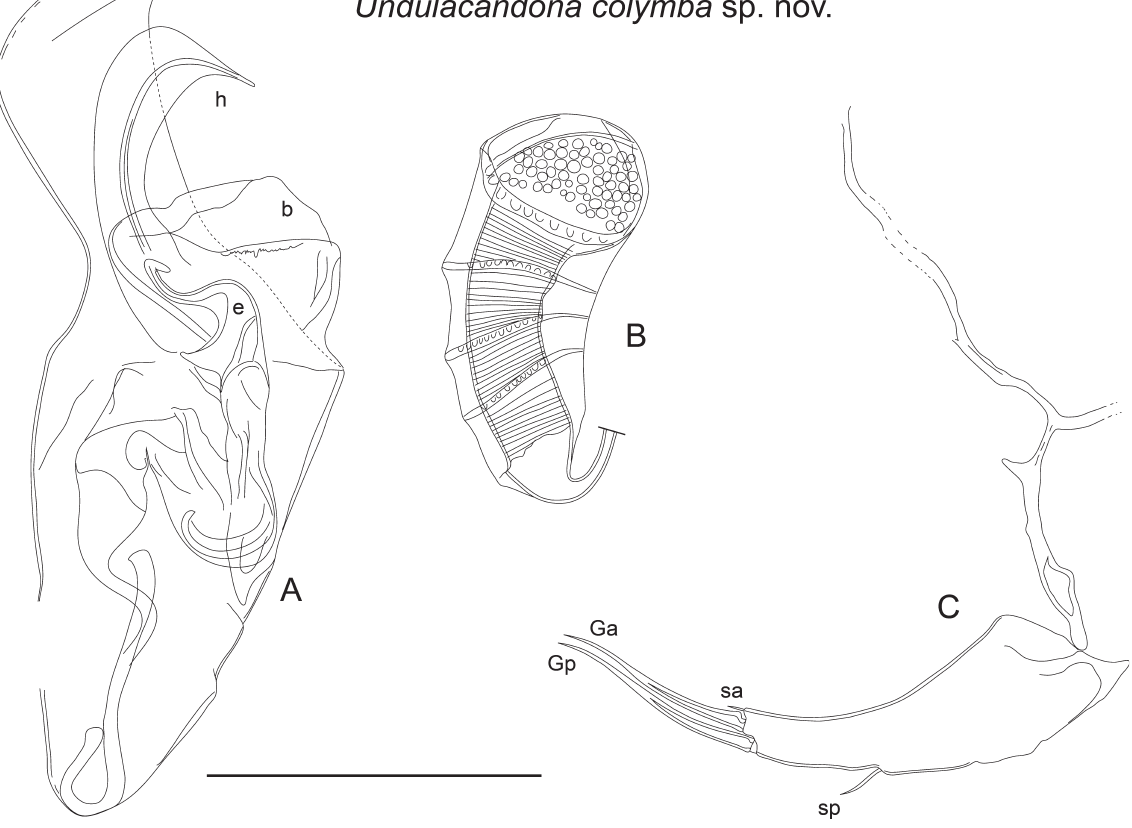
Fig. 17. Undulacandona colymba sp. nov. A . Hemipenis (LBM 1430006279). B . Zenker organ (LBM 1430006279). C . Male caudal ramus and attachment (LBM 1430006281). Scale bar = 117